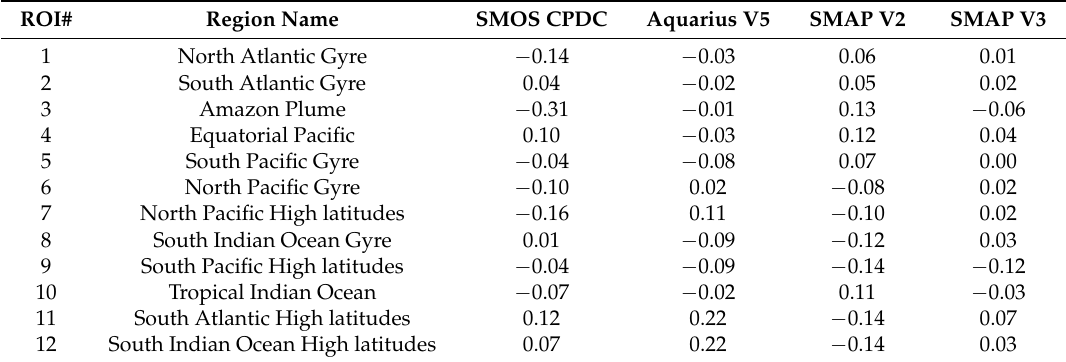
Table 7. Average (median) difference (psu) between satellite SSS and Argo SSS.